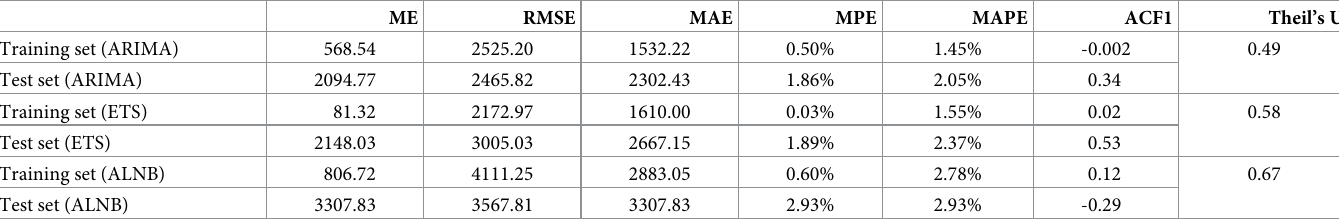
Table 3. Accuracy measures of the models based on a split in training set (January 2015 to February 2019) and test sets (March 2019 to December 2019) for the Bra- zilian data.